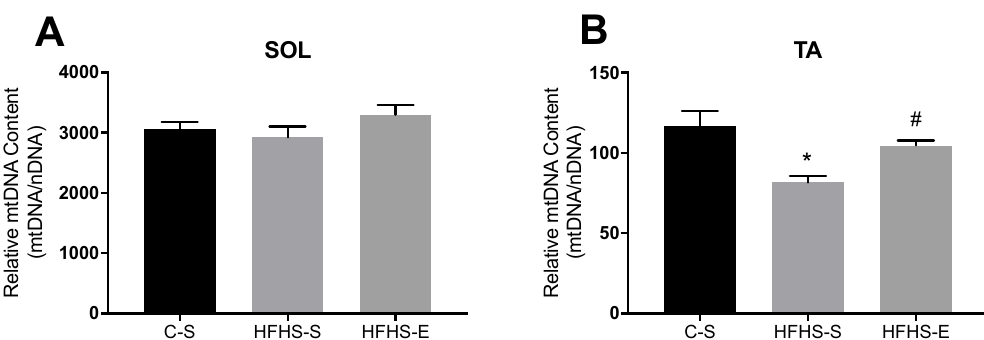
Figure 3. Effects of diet and exercise in mitochondrial DNA content of ( A ) the soleus (SOL) and ( B ) the tibialis anterior (TA) muscles. Offspring from the control diet sedentary group (C–S); offspring from the high-fat, high-sucrose diet sedentary group (HFHS–S); offspring from the high-fat, high-sucrose diet exercised group (HFHS–E), n = 6. Data are expressed as the mean ± SEM. Statistically significant differences ( p ≤ 0.05) are indicated as follows: * vs. C–S, # vs. HFHS–S. The coefficient of variation in the soleus was: 1.9% for the C–S group; 2.4% for the HFHS–S group; and2.4% in the HFHS–E group. In the tibialis anterior the coefficient of variation was: 2.6% for the C–S group; 2.1% for the HFHS–S group; and 1.8% in the HFHS–E group. Figures 4 and 5 show the relative protein content of some analyzed biomarkers asso- ciated with mitochondrial biogenesis and oxidative fitness in SOL and TA, respectively.